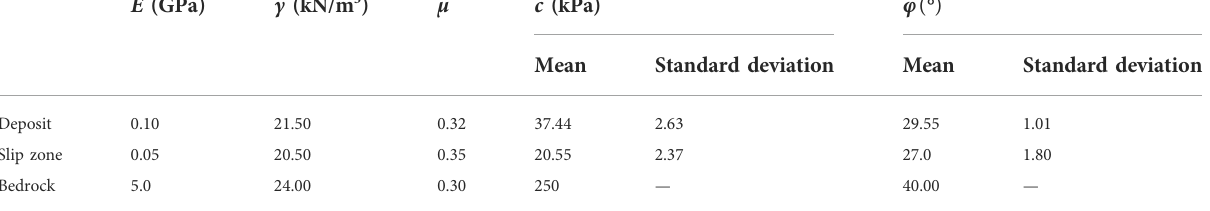
TABLE 1 Descriptive statistics parameters for the Zhenggang landslide.